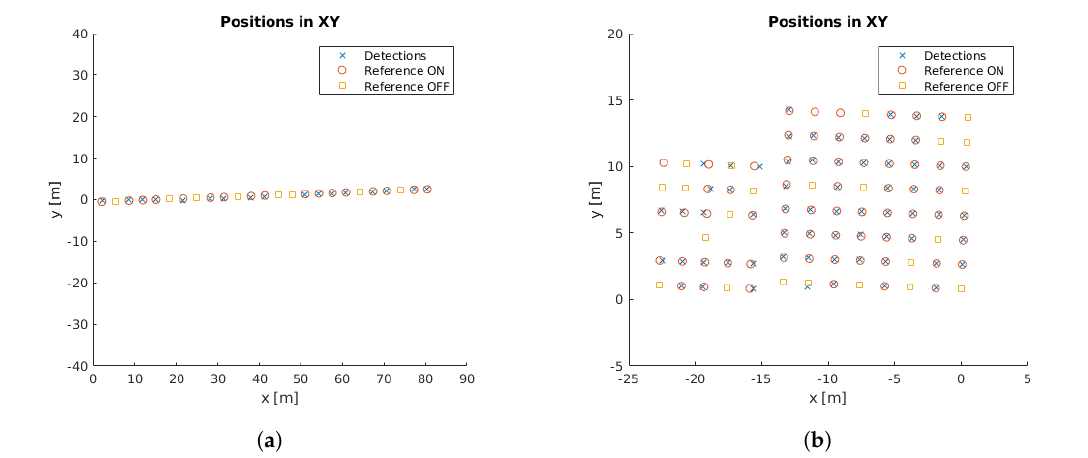
Figure 11. Position of detections and reference values with their corresponding ON/OFF state: ( a ) rectangular lamps; and ( b ) circular